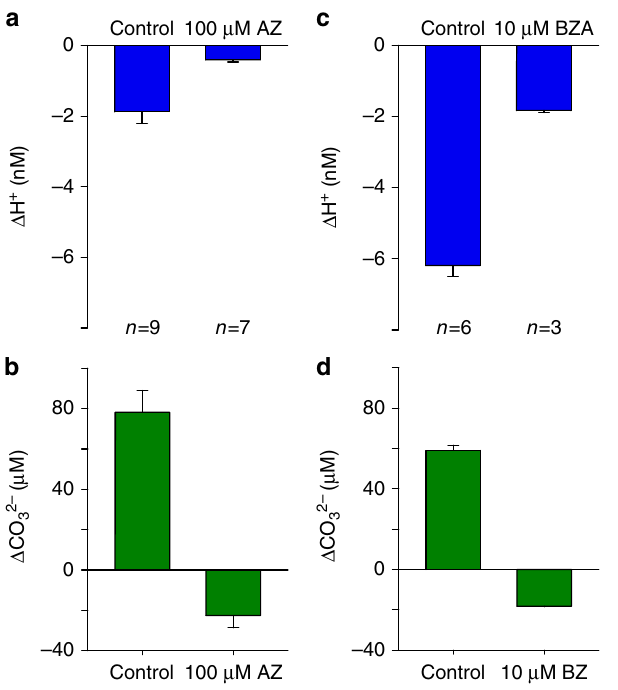
Fig. 7 The effect of eCA inhibitors on cell surface pH and CO 3 2 − . a Mean changes in cell surface [H + ] after illumination for 300 s at pH 8.2 following treatment with 100 µ M AZ. b The mean changes in [CO 3 2 − ] for cells described in a . c Mean changes in cell surface [H + ] after illumination for 300 s at pH 8.0 following treatment with 10 µ M BZA. d The mean changes in [CO 3 2 − ] for cells described in c . Error bars represent s.e.m.